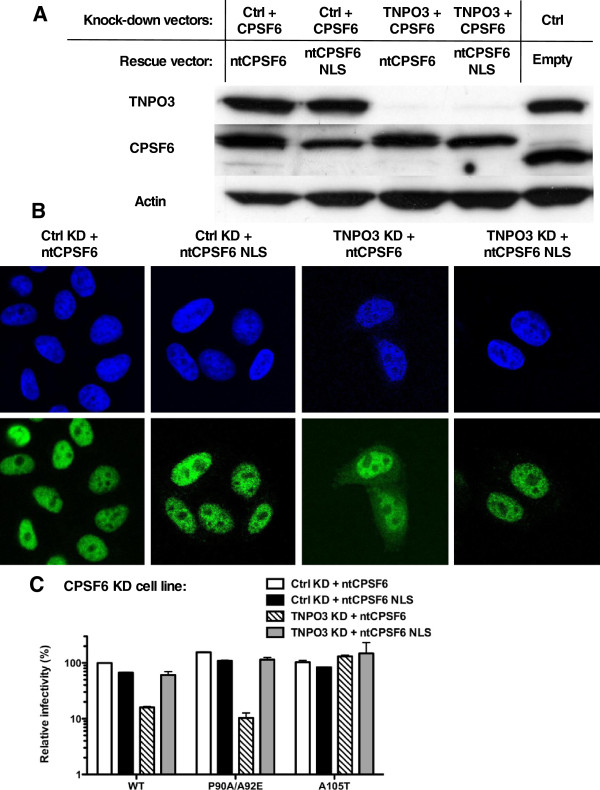
TNPO3 depletion does not inhibit HIV-1 if CPSF6 is independently targeted to the nucleus. (A) CPSF6 and TNPO3 protein in TZM-bl cells stably transduced with CPSF6 KD vectors, control or TNPO3 KD vectors, and rescue of CPSF6 (ntCPSF6) with or without the SV40 T-Ag NLS. Cell lysate was probed in western blots with anti-TNPO3 antibody (upper panel), anti-CPSF6 antibody (middle panel) and anti-β-actin antibody (lower panel). (B) Localization of the non-targetable CPSF6 (ntCPSF6) constructs (green) in control (Ctrl) KD or TNPO3 KD TZM-bl cells stably depleted of CPSF6. DAPI staining (blue) was used to mark the nuclear compartment. (C) The pools of stable cell lines in (B) were challenged with WT or CA mutant HIV-1NL4-3GFP reporter viruses. After 72 hrs, GFP expression was checked by flow cytometry. Data represent one of at least three independent experiments. Error bars represent ± SEM (n = 3).